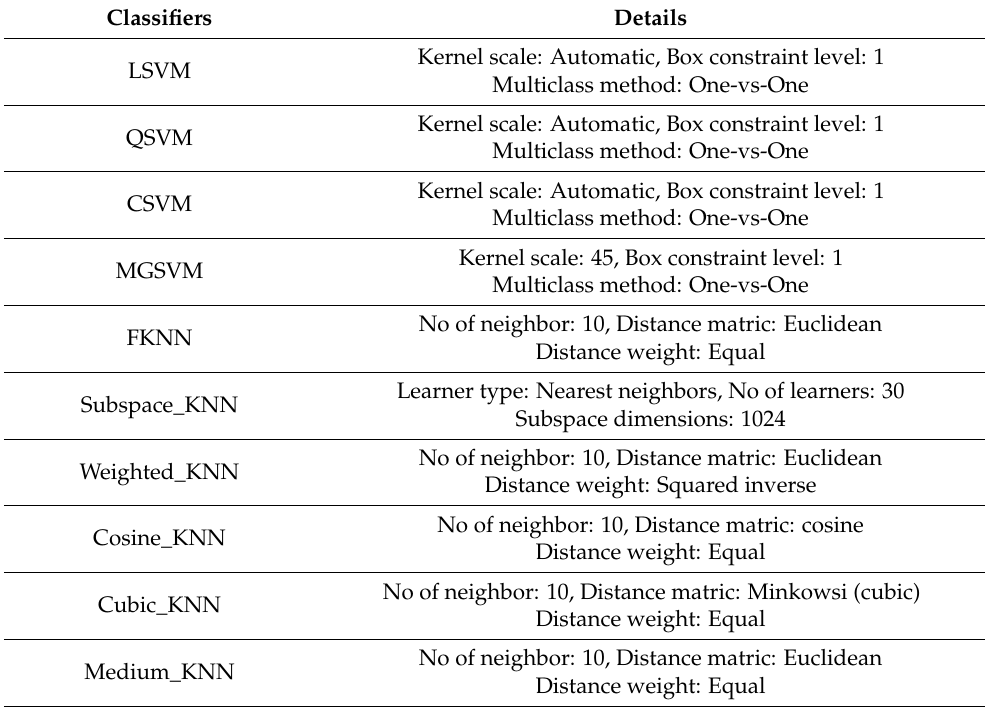
Table 1. Brief description of selected